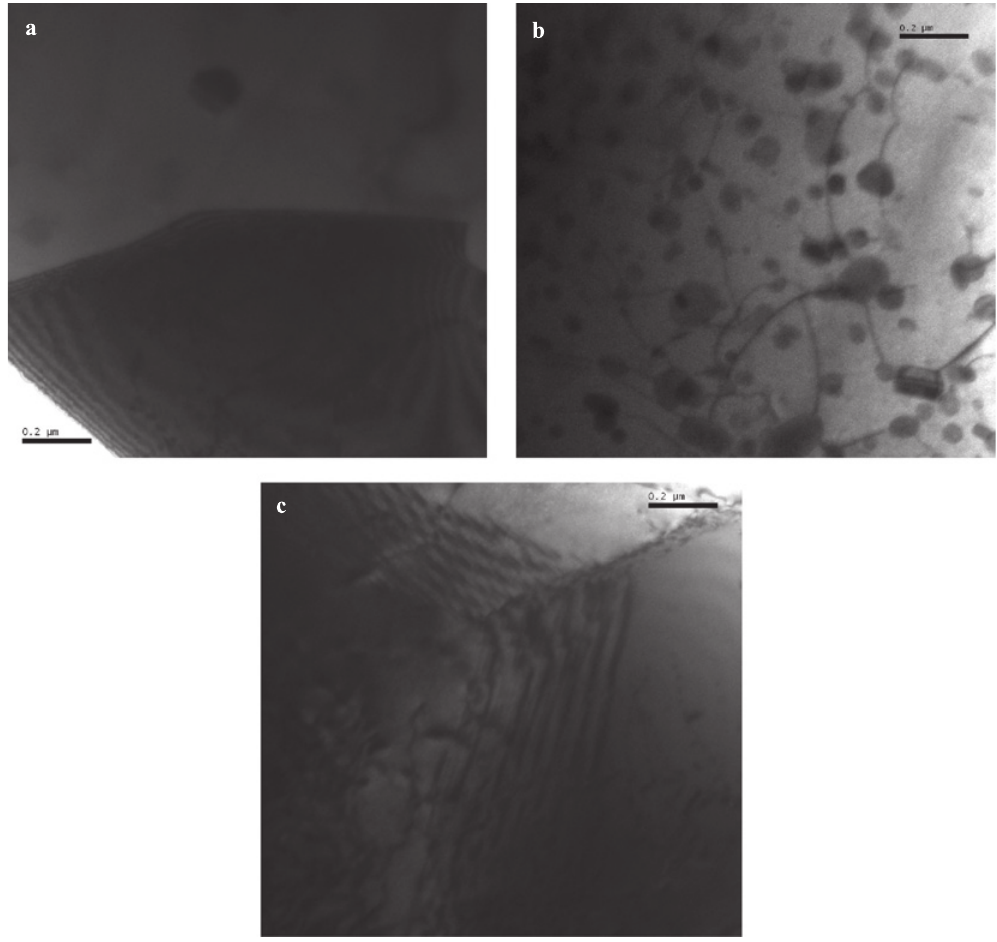
Fig. 5: The TEM Microstructure of the ECAP’ed and thixoformed AA7075; 1 passed (a), 2 passed (b), 4 passed (c)